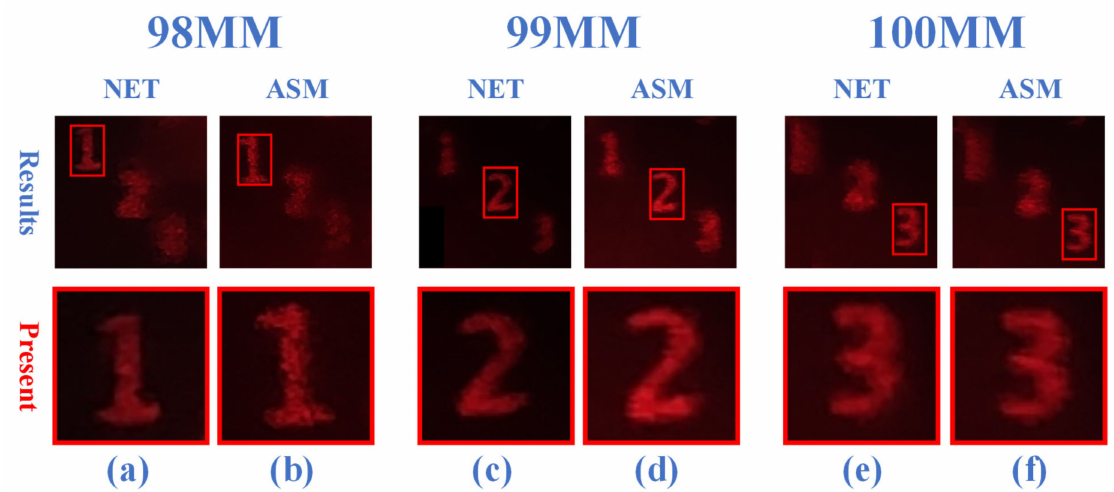
Figure 10. Comparison of optical reconstruction results of iterative ASM and network. Columns ( a , c , e ) are the optically reconstructed images of the network and their corresponding magnified images of the focused plane information; columns ( b , d , f ) are the optically reconstructed images of the iterative ASM and their corresponding magnified images of the focused plane